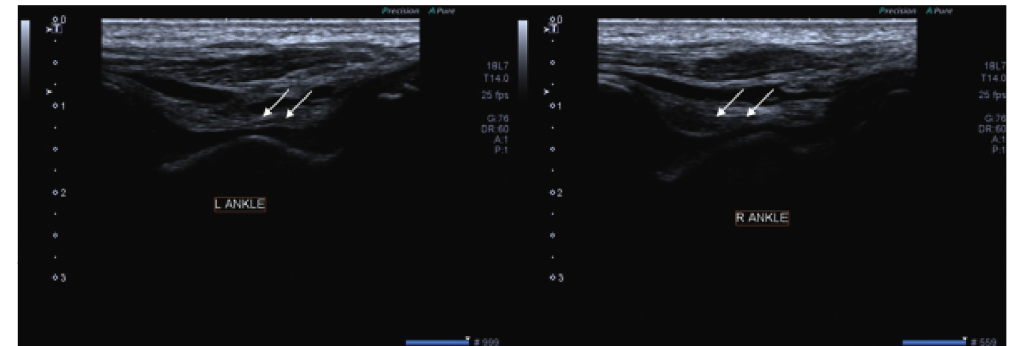
Figure 6: Grayscale images of bilateral ankle joints demonstrating moderate synovial thickening. The findings are consistent with Grade 2 synovitis (white arrows).